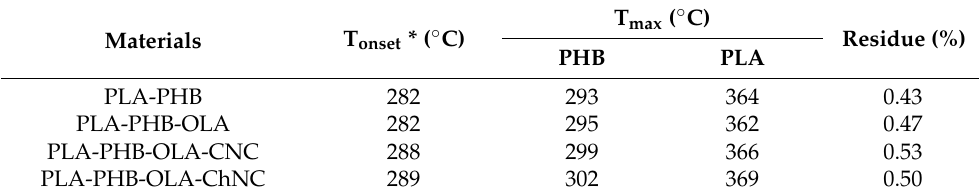
Table 3. TGA of the blown films (* T onset is initial 5% weight loss).